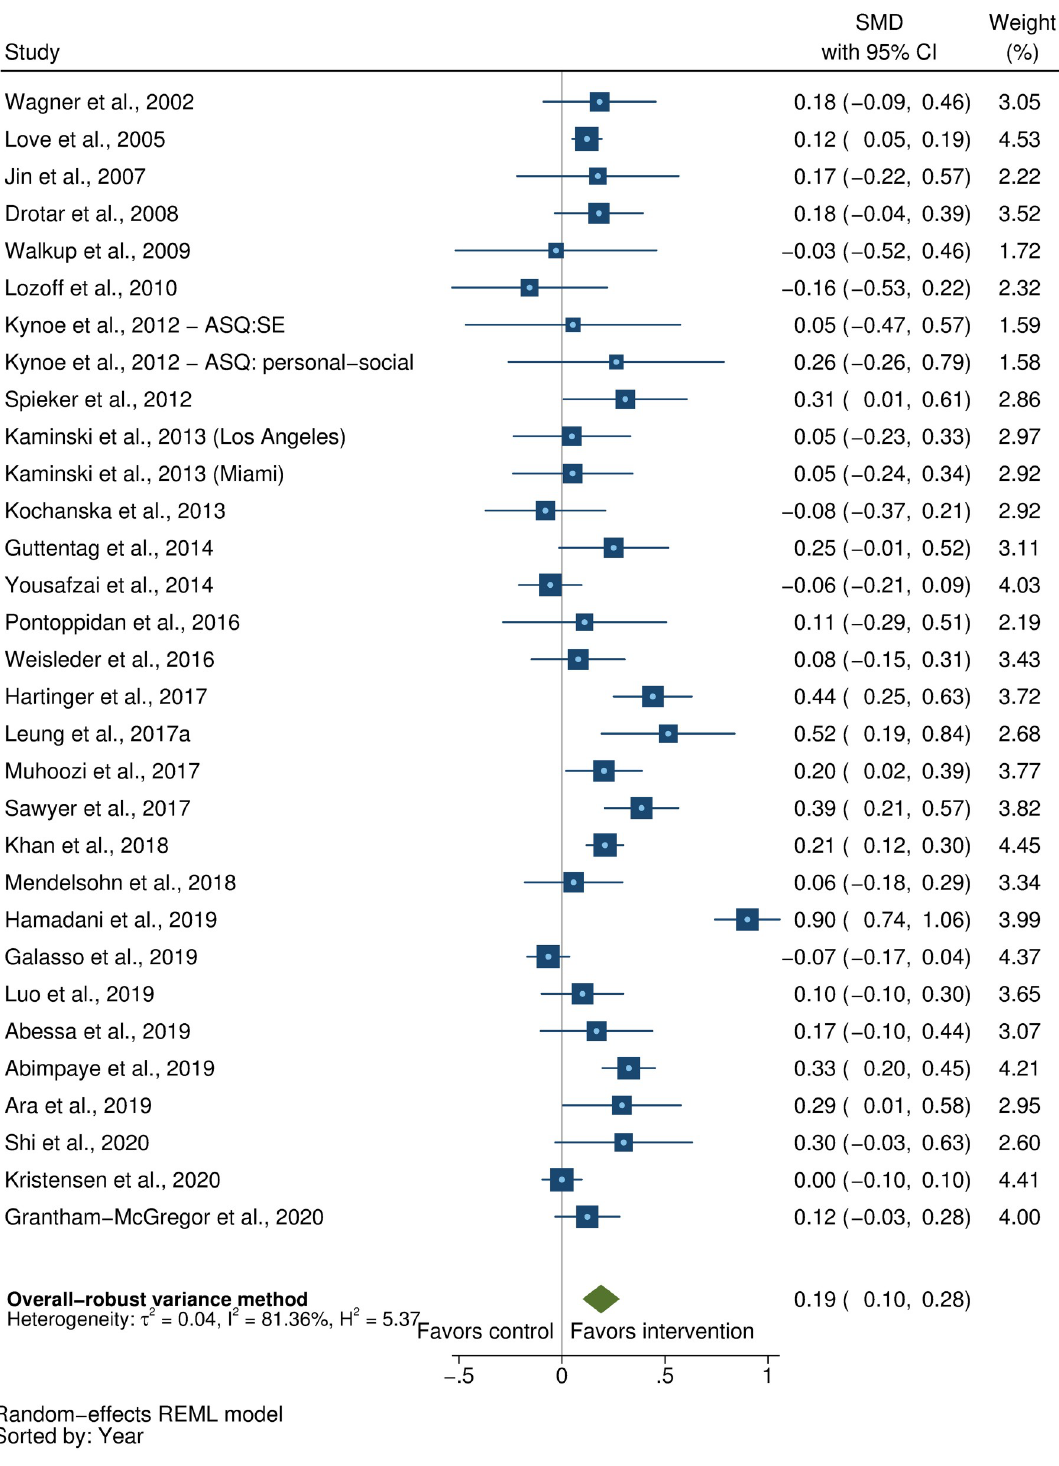
Fig 5. Forest plot for the effect of parenting interventions on socioemotional development. Blue squares represent the SMD for each study, with the size of the square being proportional to the study weight. The whiskers extending from each side of the square represent the range of the 95% CI. The green diamond shows the overall pooled effect size using a random-effects model, which is centered at the point estimate and the diamond width representing the 95% CI. SMD, standardized mean difference.